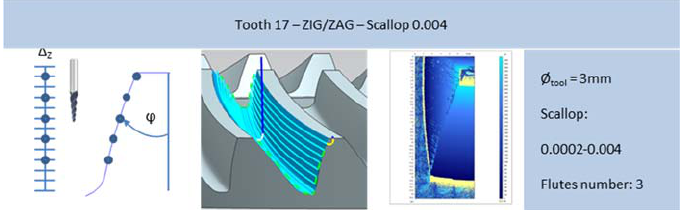
Figure 17. Form deviation results.